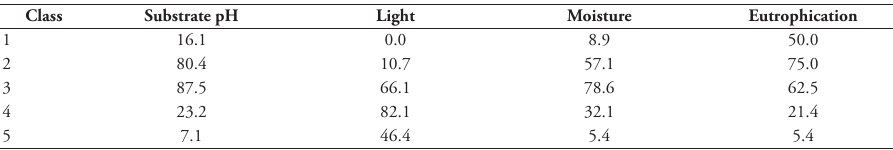
Table 2. Ecological requirements of the species represented by 4 indicator factors ranging on a five-level ordinal scale. Values in the table are percentages of species referred to the total for each of the five-levels of the ordinal scale (each species may have a range of values for each indicator